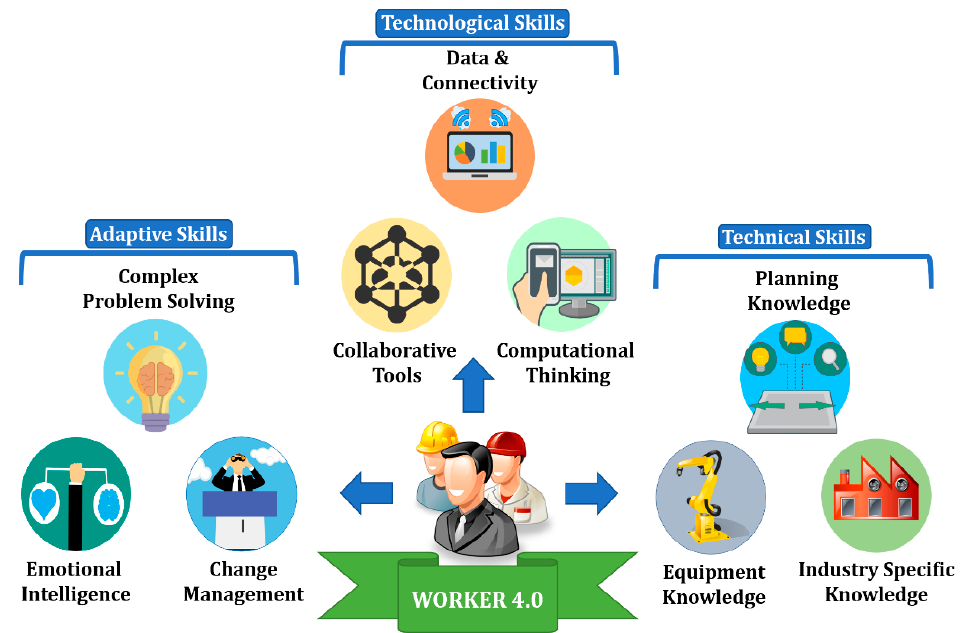
Figure 13. Worker of the future’s hybrid competencies.